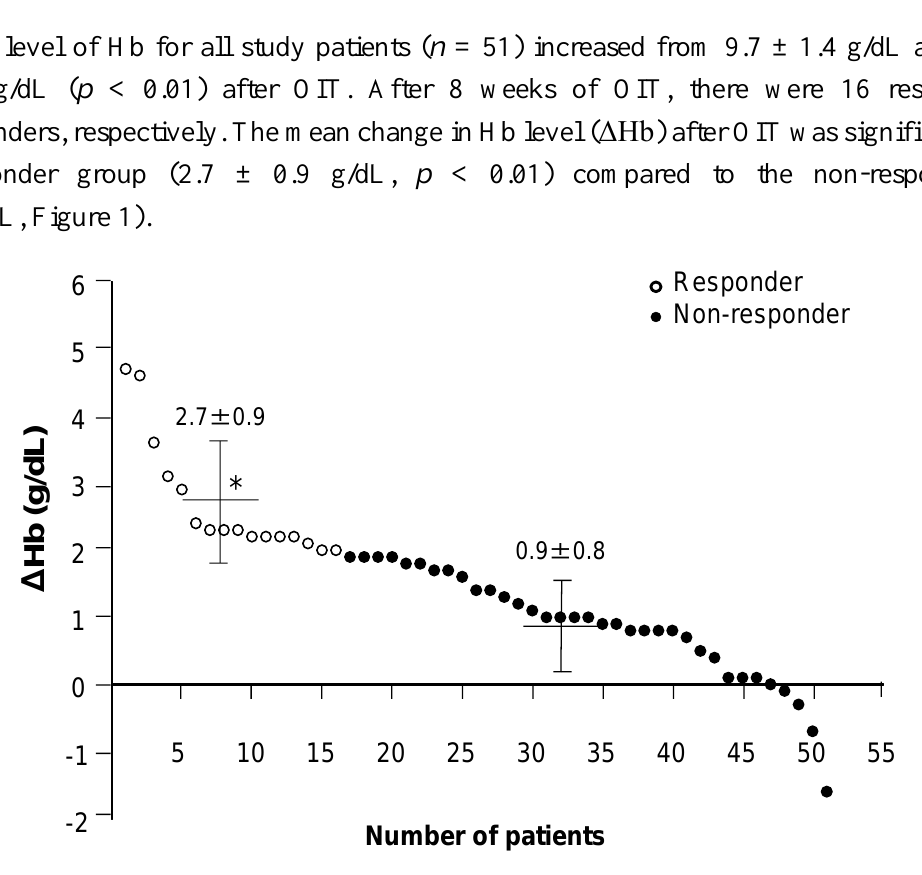
Figure 1. Distribution of ΔHb after oral iron therapy (OIT) across the total HD study population. The ΔHb after OIT was significantly higher in the responder group (2.7 ± 0.9 g/dL, n = 16) compared to the non-responder group (0.9 ± 0.8 g/dL, n = 35). Bars indicate mean ± SD. * p < 0.01, vs. non-responder group. ΔHb, change in Hb after OIT from